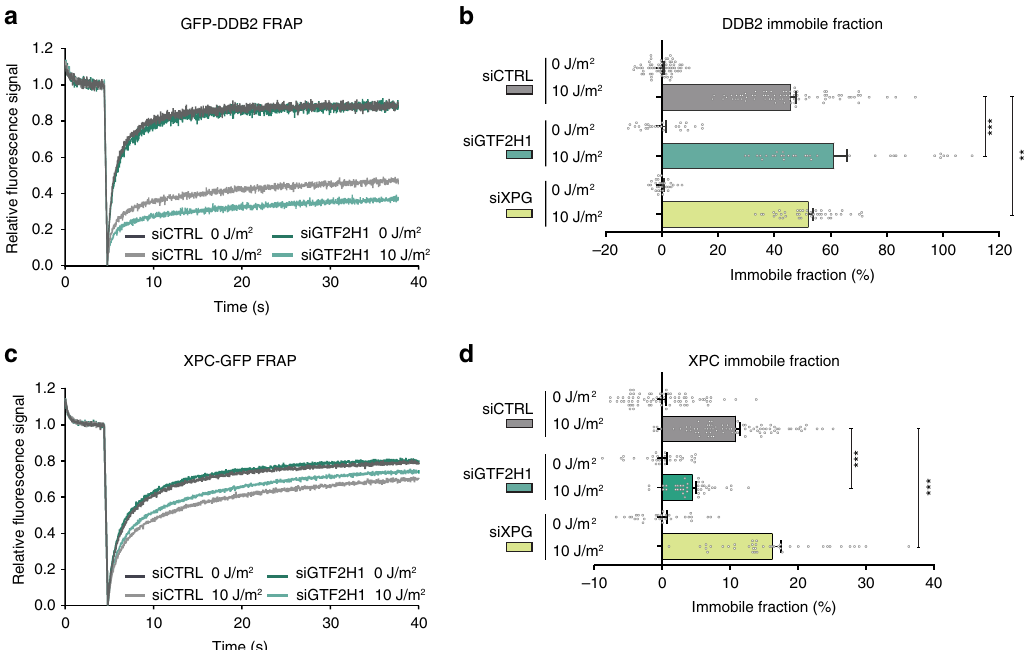
Fig. 1 DDB2 and XPC are differently regulated by downstream factors. a Fluorescence Recovery After Photobleaching (FRAP) analysis of DDB2 mobility in mock or UV-C irradiated (10 J/m 2 ) VH10 cells stably expressing GFP-DDB2 and transfected with control (CTRL) or GTF2H1 siRNAs. GFP-DDB2 fl uorescence recovery was measured in a strip across the nucleus after bleaching, normalized to bleach depth, and the average pre-bleach intensities (1.0). b Percentage of GFP-DDB2 immobile fraction in VH10 fi broblasts treated with control (CTRL), GTF2H1 or XPG siRNAs, determined from FRAP analyses as depicted in ( a ). Percentage immobile fraction represents the ratio between the average recovered fl uorescence intensity of UV- and mock-treated cells, over the last 10 s of the measurements, as explained in the methods. c FRAP analysis of XPC mobility in mock or UV-C irradiated (10 J/m 2 ) XP4PA cells stably expressing XPC-GFP and transfected with control (CTRL) or GTF2H1 siRNAs. XPC-GFP- fl uorescence recovery was measured and normalized as described in ( a ). d Percentage of XPC-GFP immobile fraction in XP4PA cells treated with control (CTRL), GTF2H1 or XPG siRNAs, determined by FRAP analysis as depicted in ( c ) and described in ( b ). Graphs and FRAP curves depict the mean & S.E.M. of >30 cells from three independent experiments. ** P < 0.01, *** P < 0.001, relative to siCTRL control 10 J/m 2 , analyzed by unpaired, two-tailed t -test (adjusted for multiple comparisons, see “ Methods ” ). Source data are provided as a Source Data fi